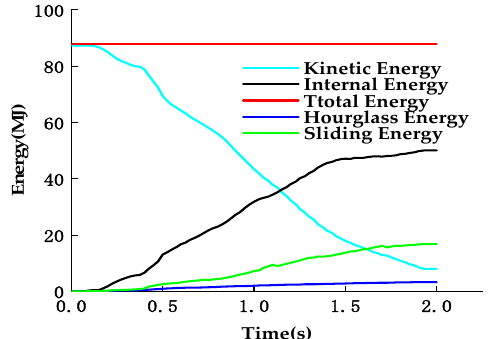
Figure 13. Energy diagram of the UHPC supporting.